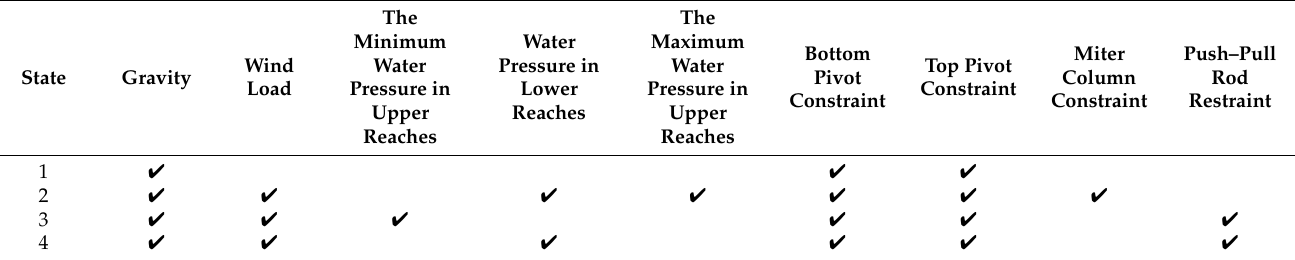
Table 2. Stress load and constraint of the gate under different